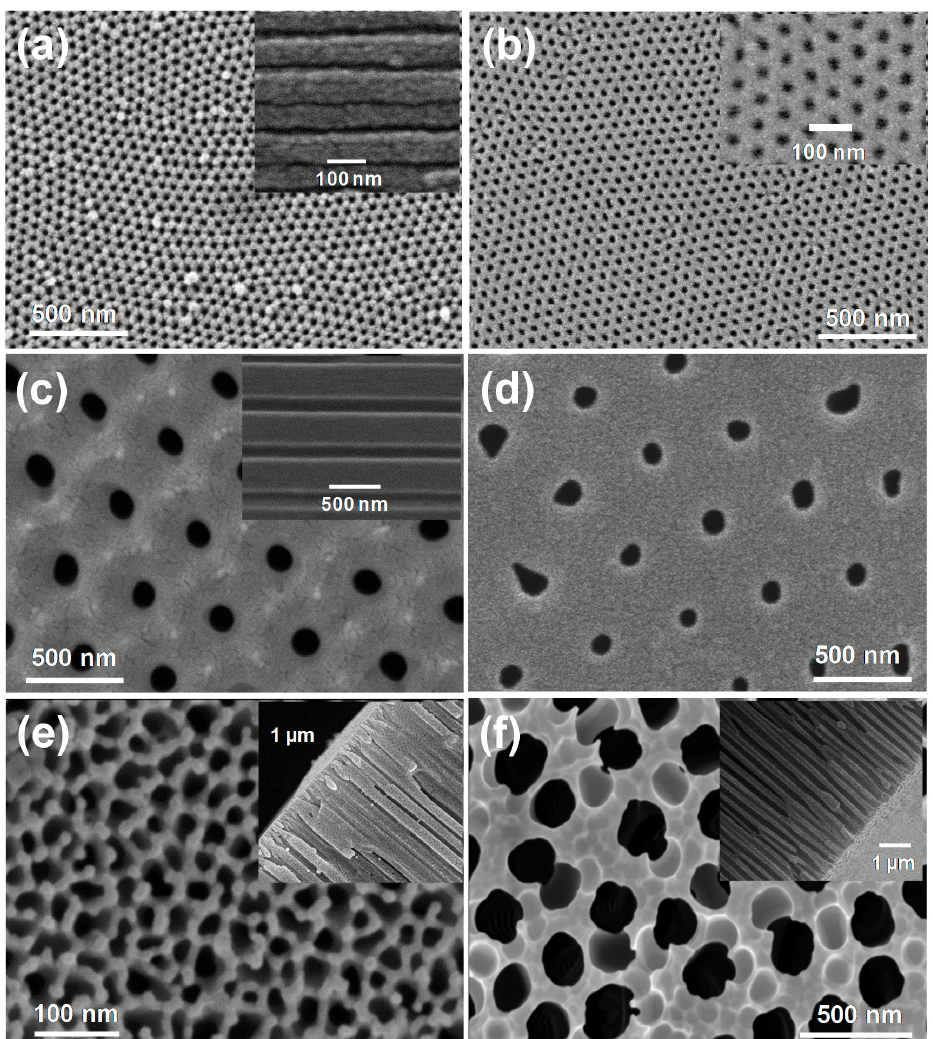
Figure 2. SEM micrographs of NPASs: NPAS-Sf top view ( a ) and bottom view ( b ); NPAS-Ph top view ( c ) and bottom view ( d ); Anopore: bottom view ( e ) and top view ( f ). The insets in ( a ), ( c ), ( e ), and ( d ) show cross section views of the respective samples. The inset in ( b ) shows a higher magnification image to make pore size clearly visible.